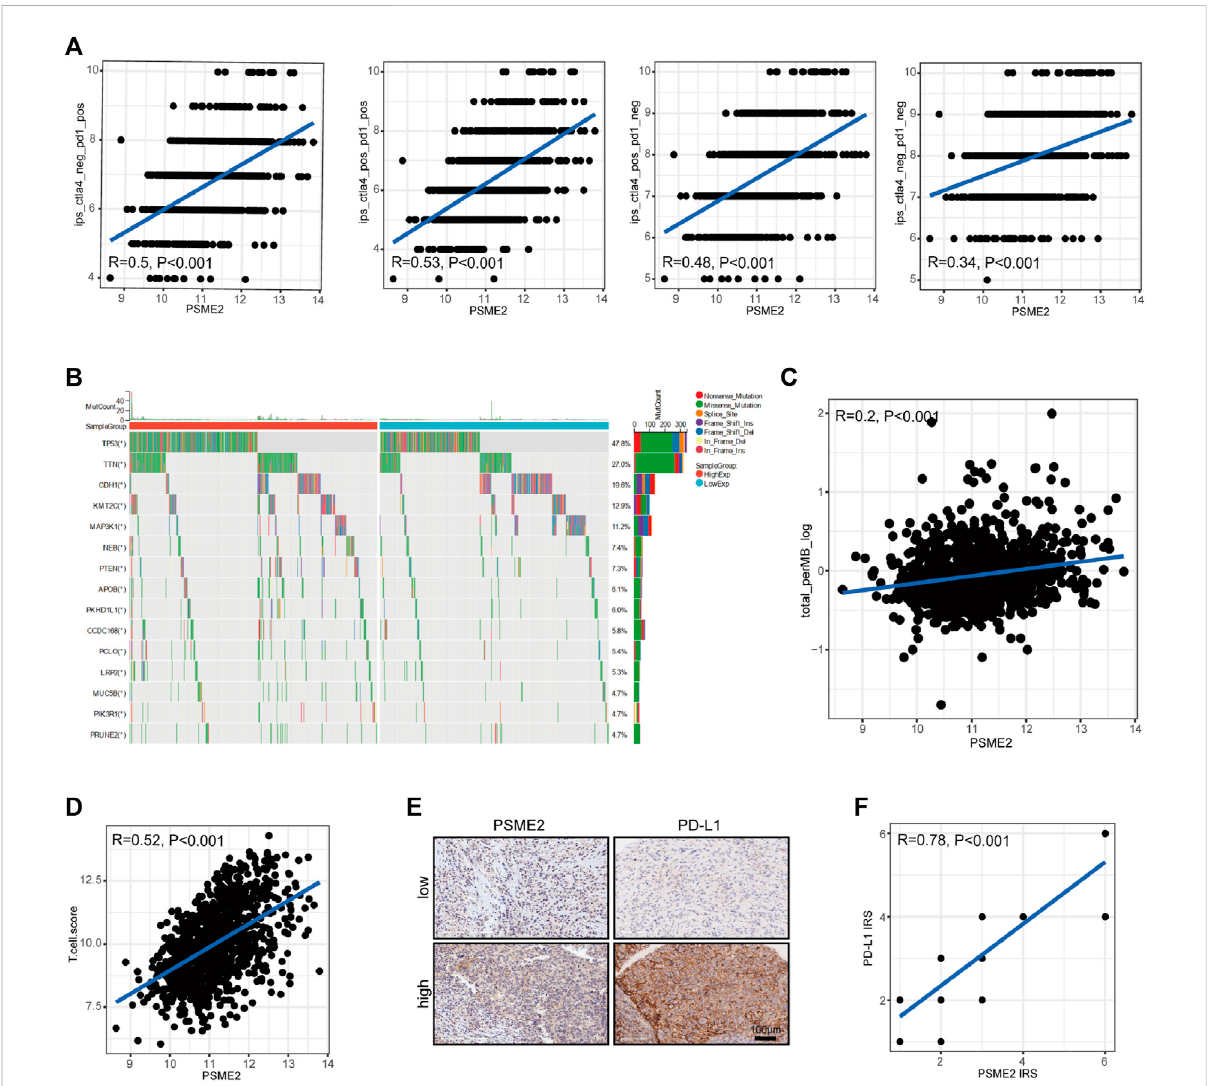
Associations between PSME2 and immunotherapy biomarkers in BrCa (A) Positive correlations between PSME2 and the IPS (B) The altered landscapes of common genes in BrCa (C) Positive correlation between PSME2 and the TMB level (D) Positive correlation between PSME2 and the T cell infamed score. Data of A-D was obtained from the TCGA dataset (E) Representative images revealing low and high PSME2 and PD-L1 expression using anti-PSME2 staining. Magni fi cation, ×200 (F) Positive correlation between PSME2 and PD-L1 protein